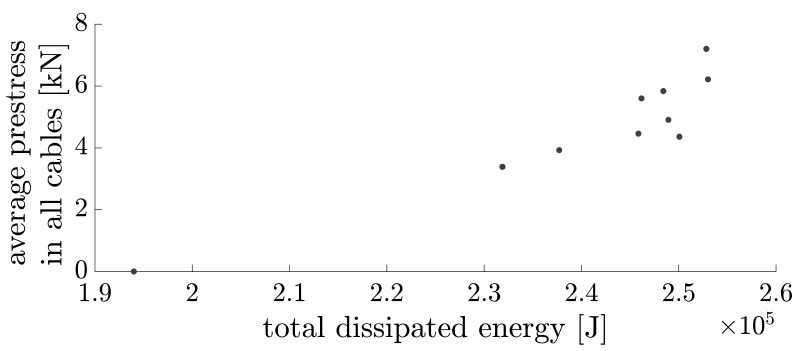
Figure 22. Global energy variation according to the average prestress in all cables.